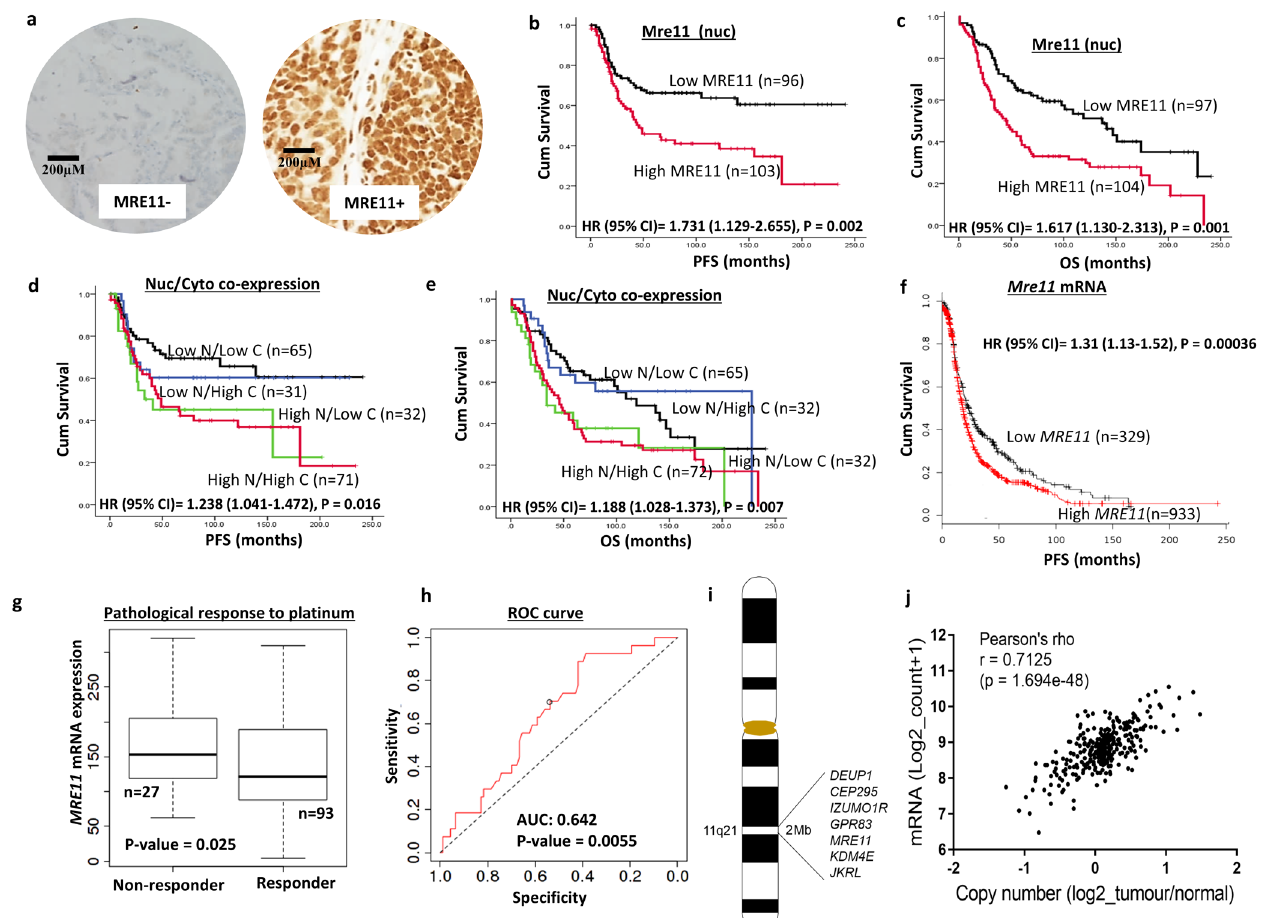
Fig. 1 Clinicopathological studies of MRE11 expression in ovarian cancers. a Immunohistochemical expression of Mre11in ovarian cancers. In Mre11 positive tumour (right panel), nuclear Mre11 H-score was 280. b Kaplan-Meier curve for Mre11nuclear protein expression and progression free survival (PFS) in ovarian cancers ( c ) Kaplan-Meier curve for Mre11nuclear protein expression and overall survival (OS) in ovarian cancers. d Kaplan-Meier curve for Mre11 nuclear & cytoplasmic co-expression and progression free survival (PFS) in ovarian cancers. e Kaplan-Meier curve for Mre11nuclear &cytoplasmic co-expression and overall survival (OS) in ovarian cancers. f Kaplan Meier curve for Mre11 mRNA expression and progression free survival (PFS) in ovarian cancers. g Pathological response to platinum and Mre11 mRNA expression between non responders ( n = 27) and responders to platinum ( n = 93). Box Plot- lower whisker [Minimum ( Q 0 or 0th percentile)] is the lowest data point in the data set excluding any outliers. Upper whisker [Maximum ( Q 4 or 100th percentile)] is the highest data point in the data set excluding any outliers. Central line [Median ( Q 2 or 50th percentile)]is the middle value in the data set. Bounds of the box - First quartile ( Q 1 or 25th percentile) is the median of the lower half of the dataset. Third quartile ( Q 3 or 75th percentile) is the median of the upper half of the dataset. The box is drawn from Q 1 to Q 3 with a horizontal line drawn in the middle to denote the median. h Receiver operating characteristics (ROC) for Mre11 mRNA expression and platinum response. i Region of gene enrichment covers 2 Mb region of Chr11q21. j Correlation between RNAseq mRNA levels and copy number ( n = 305) shows signi fi cant positive correlation r = 0.7125, p <